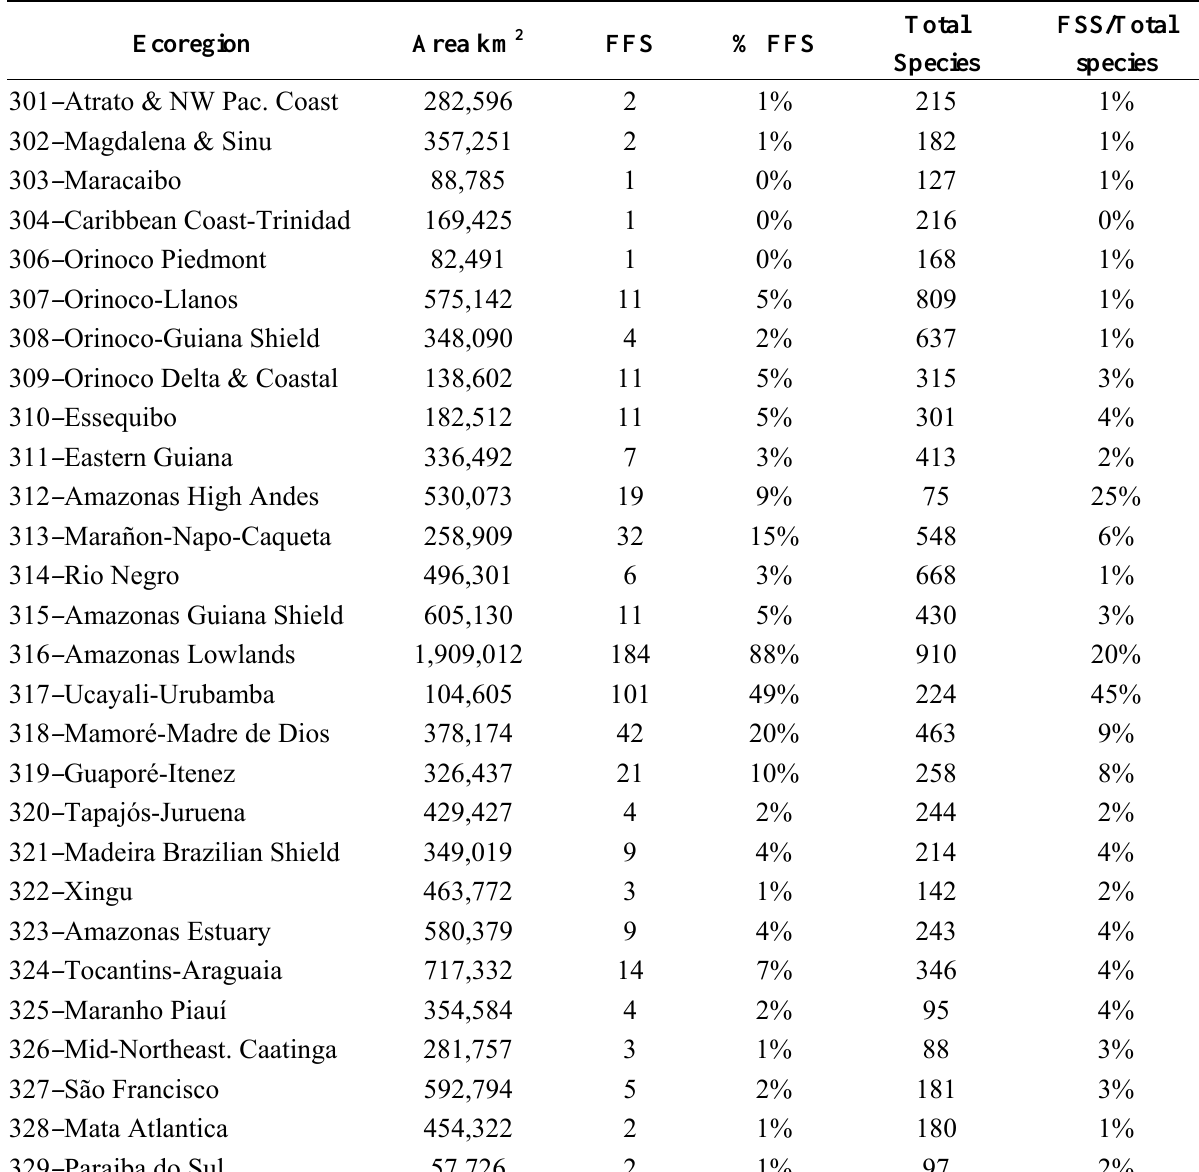
Table 1. Distribution of known Fitzcarrald fish species (FFS) among the freshwater ecoregions of tropical South America. Data for 208 FFS in 39 ecoregions extending over about 13.9 million km 2 . Ecoregions not listed have no FFS. Minimum number of total fish species per ecoregion from Albert et al. (2011, table 2.1). Note the greatest number of FFS in Amazonas Lowlands (184 species, or 88% of FFS pool). Note also FFS constitute a higher proportion of the total fish fauna in the Ucayali-Urubamba ecoregion (45%) than any other